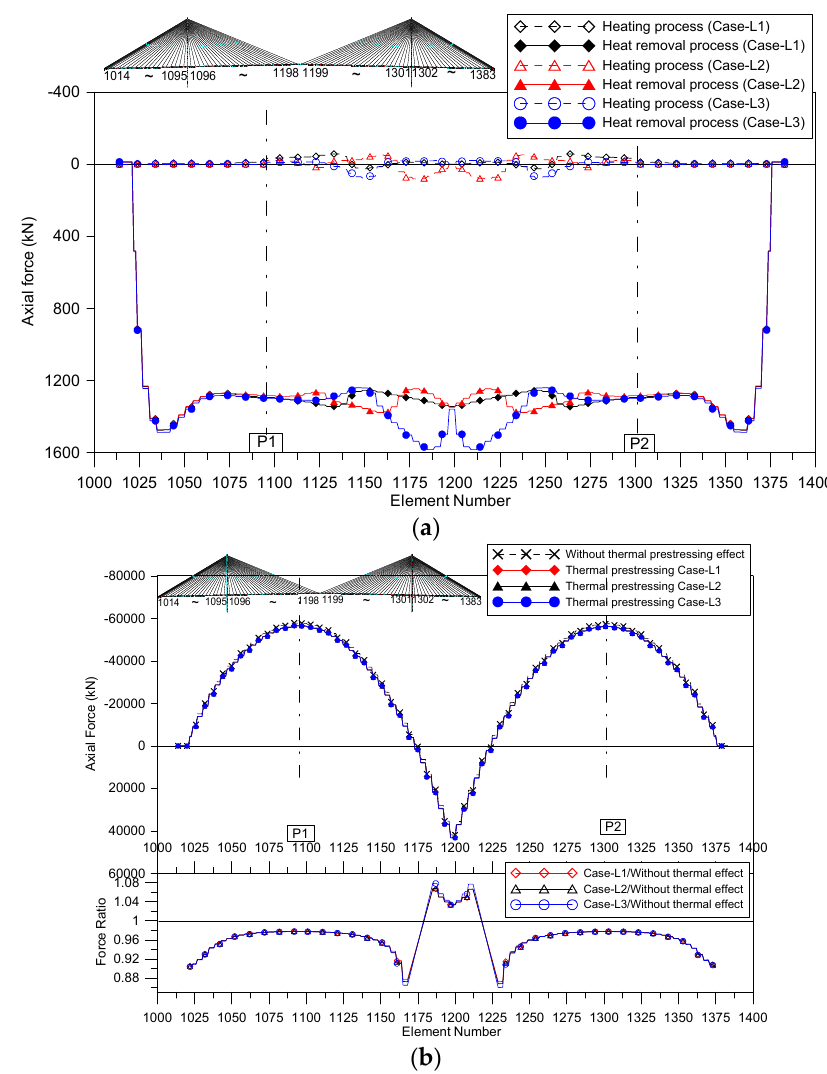
Figure 8. Girder axial forces according to the heating region. ( a ) Axial forces generated by heating and heat removal processes; ( b ) Axial forces after completed construction.